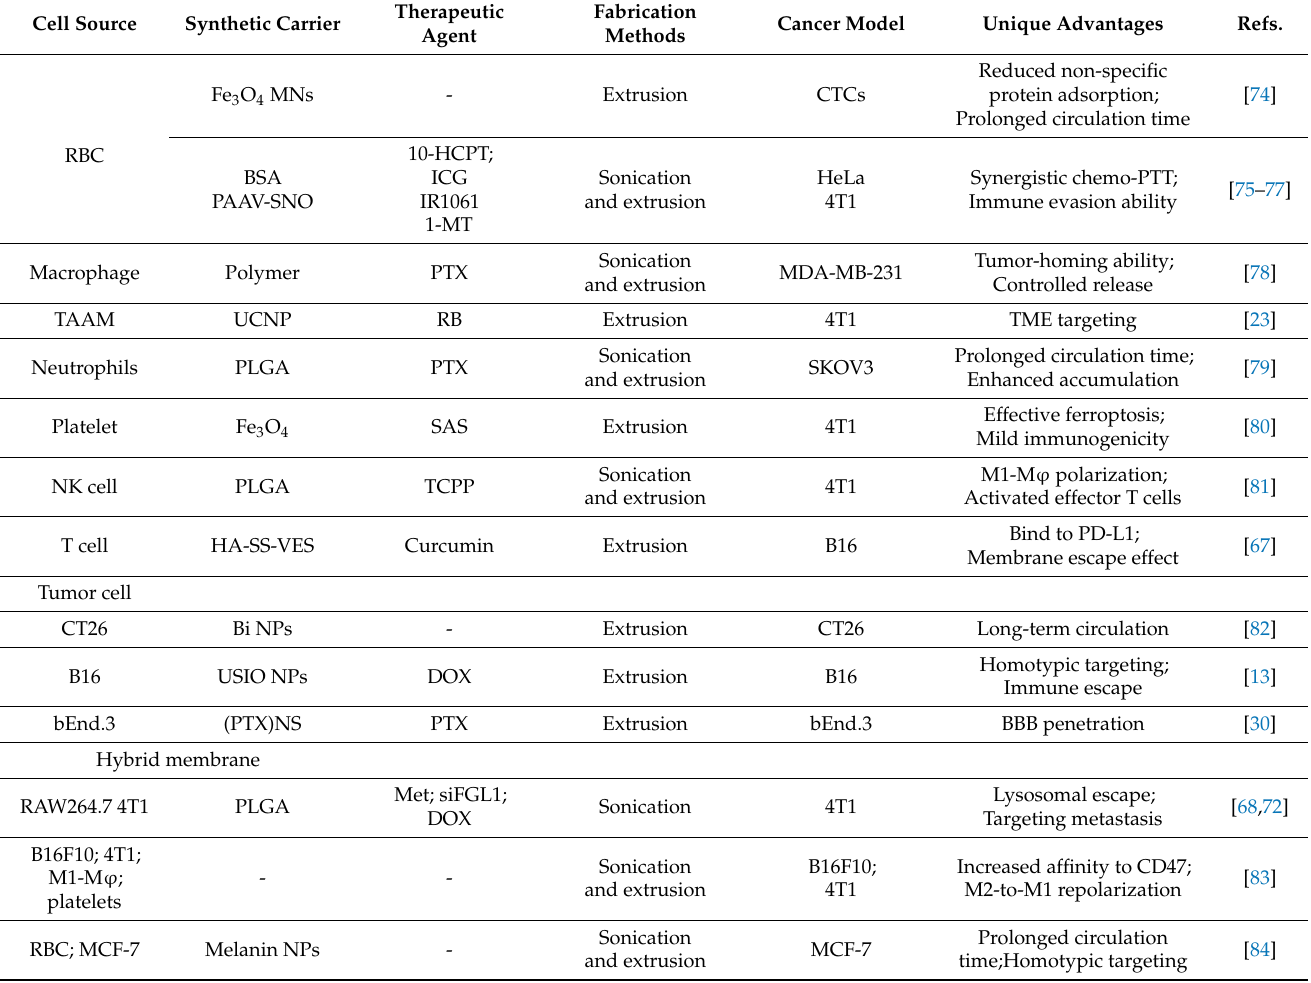
Table 1. Summary of cell membrane-camouflaged nanomedicines for cancer